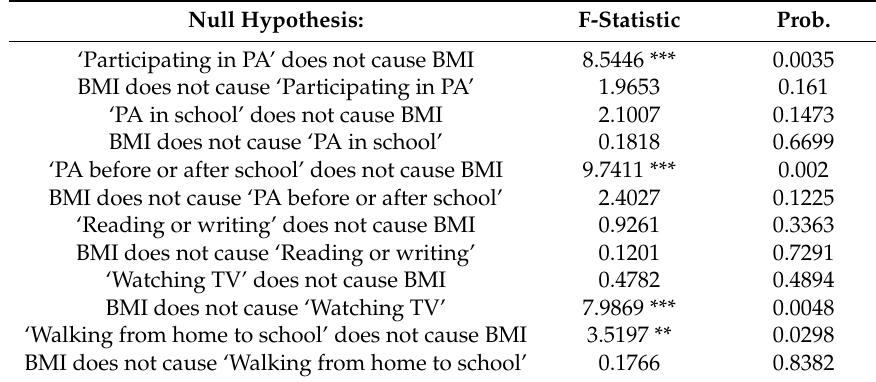
Table 3. Pairwise Granger Causality Tests with 1